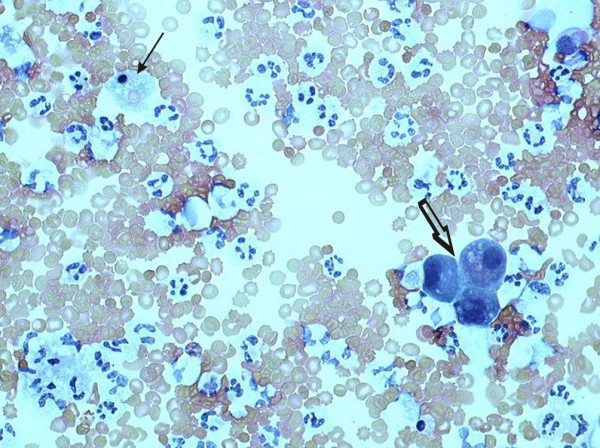
Bronchoalveolar lavage: predominance of neutrophil cell population, hemorrhage with erythrophagocytosis (black arrow) and desquamated type II pneumocytes (white arrow). Papanicolaou staining; magnification × 400.